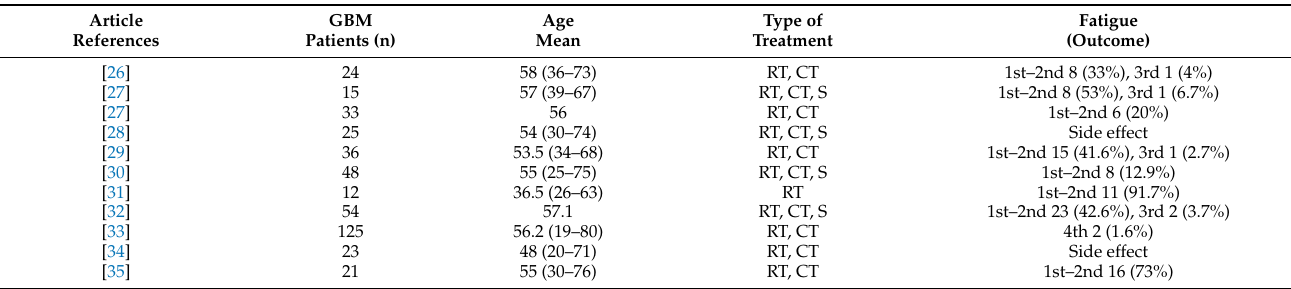
Table 1. Main study characteristics of the included